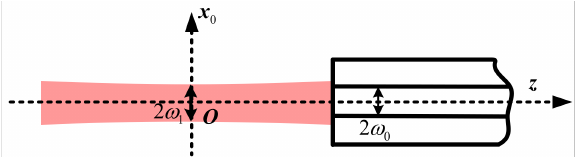
Figure 3. The principle of fiber coupling with Gaussian beam.